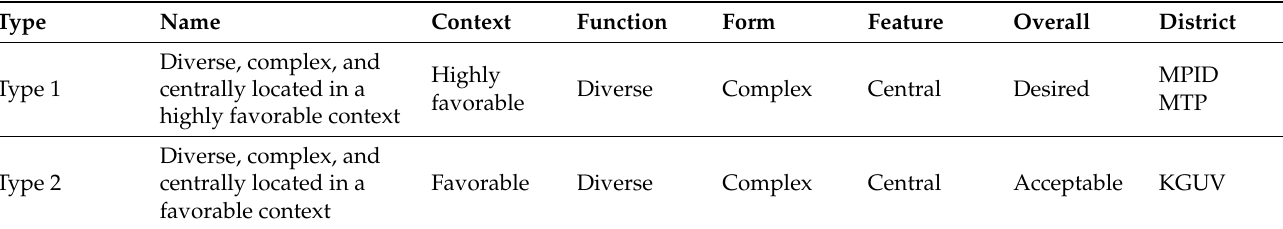
Table 5. Typology matrix of the case innovation